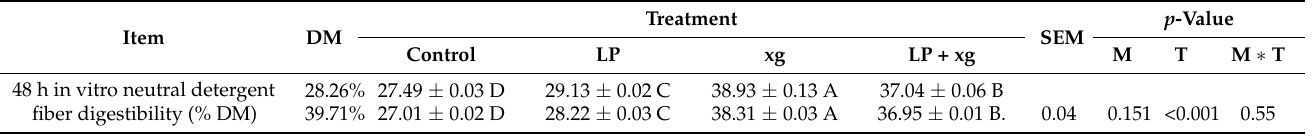
Table 9. In vitro neutral detergent fiber digestibility of Stylosanthes silage.